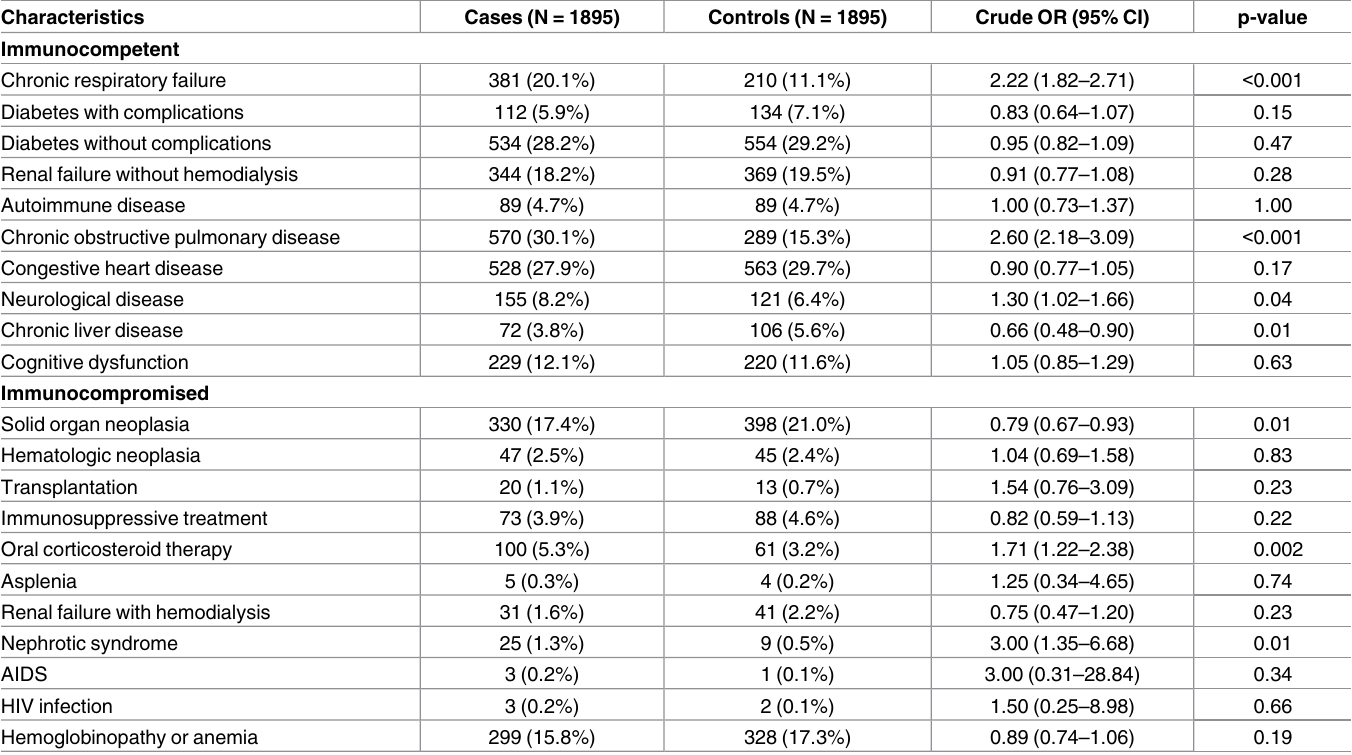
Table 2. Distribution of cases and controls according to comorbidities.